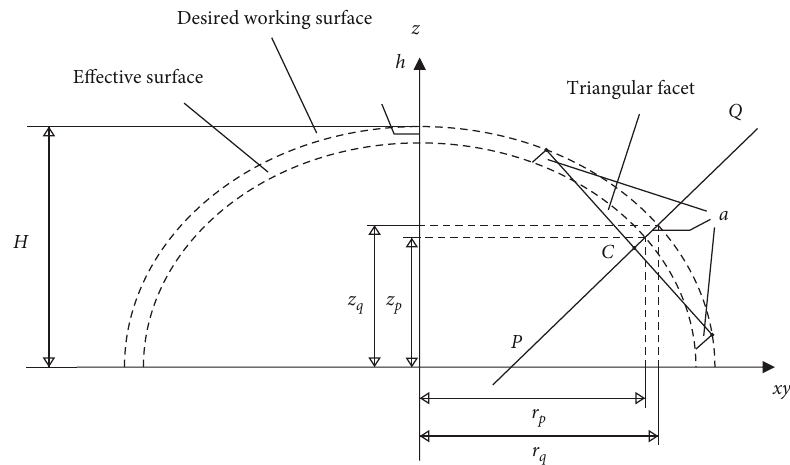
Figure 8: Geometries of desired working surface, e ff ective surface, and a